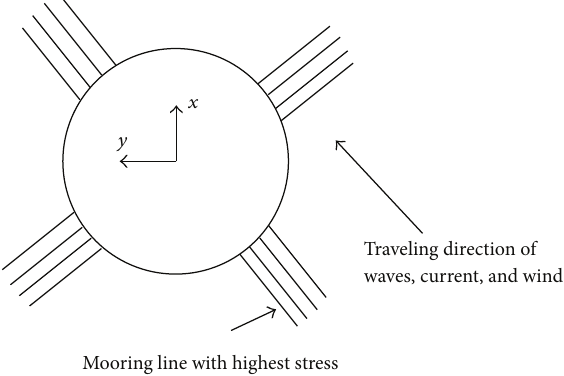
Figure 3: Mooring line system (top